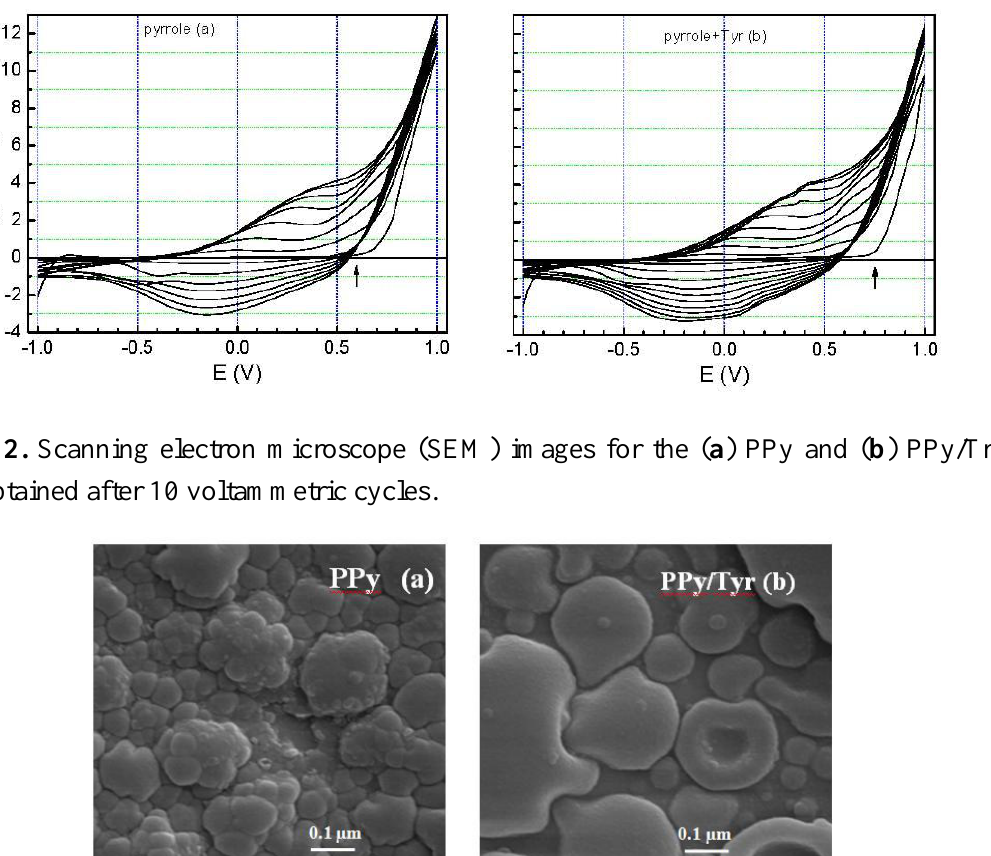
Figure 1. Cyclic voltammograms during the preparation of the PPy ( a ) and PPy/Try ( b ) films in 0.1 mol∙L −1 LiClO , 0.07 mol∙L −1 pyrrole, without (a), and with (b), crude extract 4 of avocado at a fixed volume (100 µL).